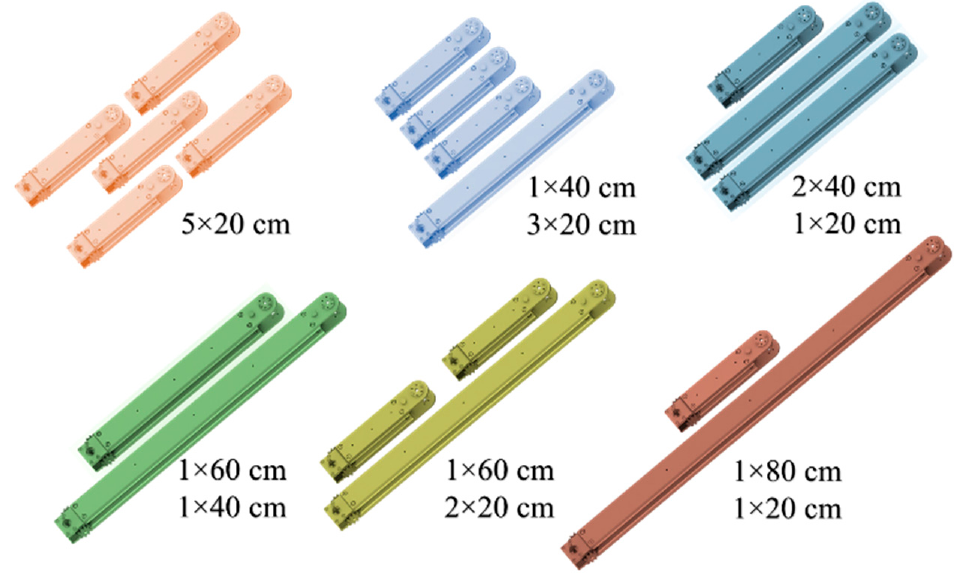
Figure 2. Number of assemblies to form a one-meter arm using different combinations of links with lengths that vary from 20 cm to 80 cm. In the case of a pick-and-place task, the optimal combination will use the minimal number of links.